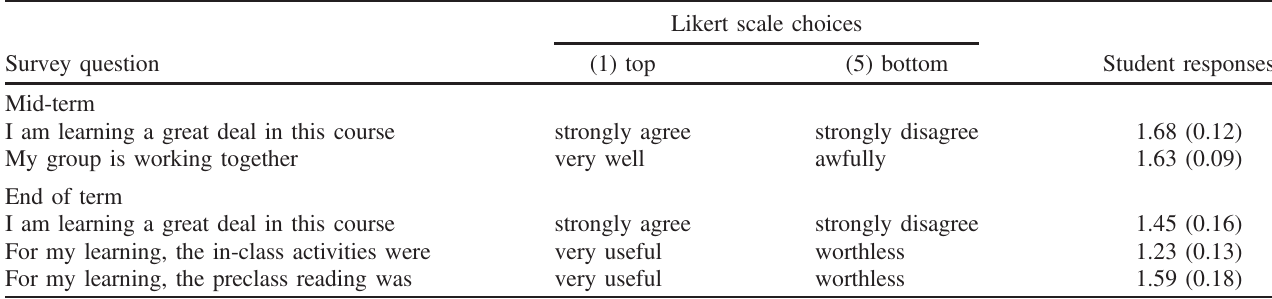
TABLE VI. Results from two attitude surveys in the first transformed year with average response. The standard error is shown in